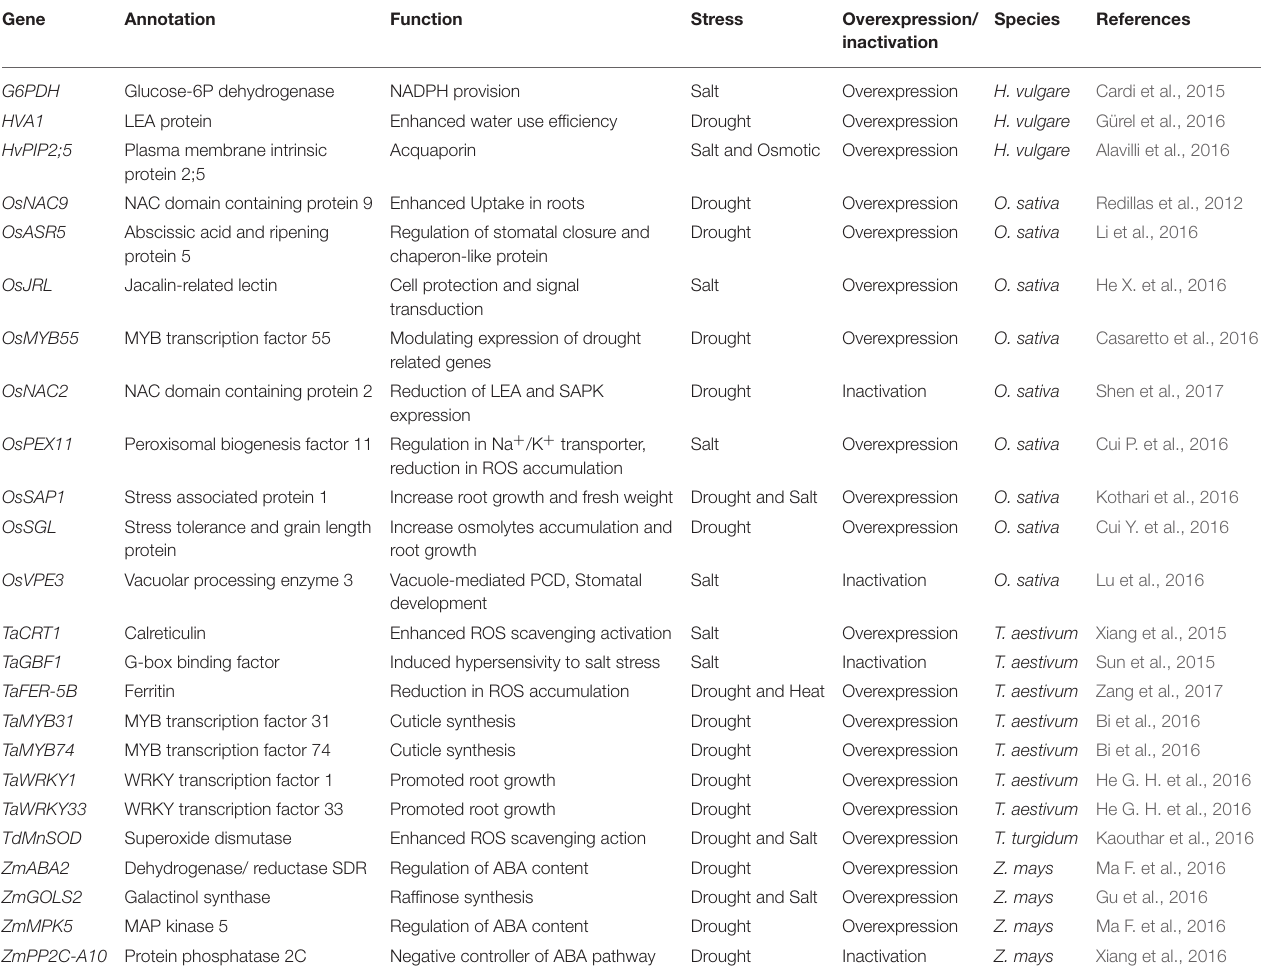
TABLE 1 | List of genes conferring abiotic stress tolerance in Poaceae